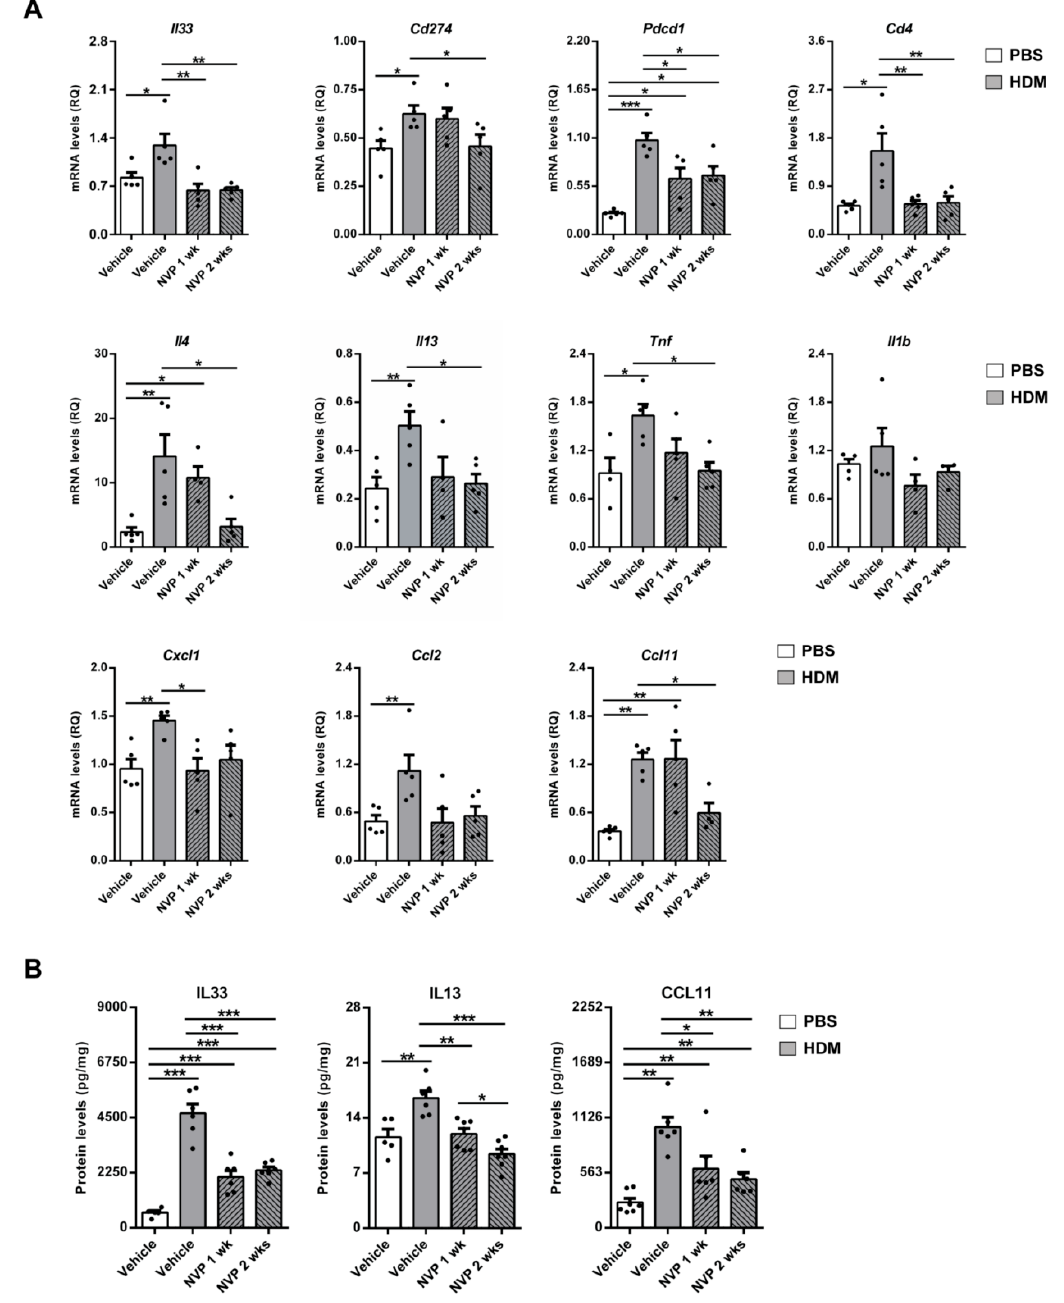
Figure 5. Therapeutic inhibition of IGF1R diminishes expression of allergic airway inflammation markers after HDM exposure. ( A ) Lung tissue mRNA expression levels of Il33 (dendritic cell activation), Cd274 (PD-L1) and Pdcd1 (PD-1) (T cell response), Cd4 (T cell marker), Il4 and Il13 (Th2 cytokines), Tnf and Il1b (Th1 cytokines), Cxcl1 (neutrophil chemotaxis), Ccl2 (macrophage chemotaxis) and Ccl11 (eosinophil chemotaxis) normalized to 18S expression in HDM-challenged mice treated with NVP vs. controls ( n = 5 mice per group). ( B ) IL33, IL13 and CCL11 protein levels in lung homogenates from HDM-challenged mice treated with NVP vs. controls ( n = 5–7 mice per group). Data are expressed as mean ± SEM. * p < 0.05; ** p < 0.01; *** p < 0.001 (Mann–Whitney U test or Student´s t -test for comparing two groups and Kruskal–Wallis test or ANOVA multiple comparison test for grouped or multivariate analysis).